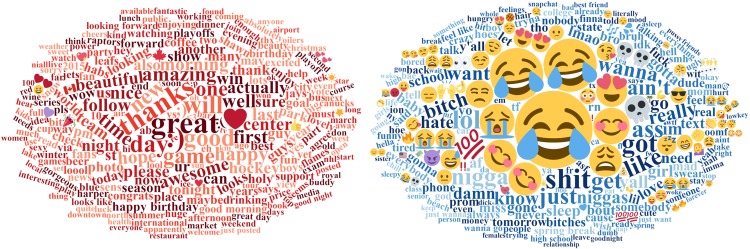
250 most Canadian and American words.The top 250 US and Canadian words. Text size is proportional to LORIDP z-score. Color is for readability only.